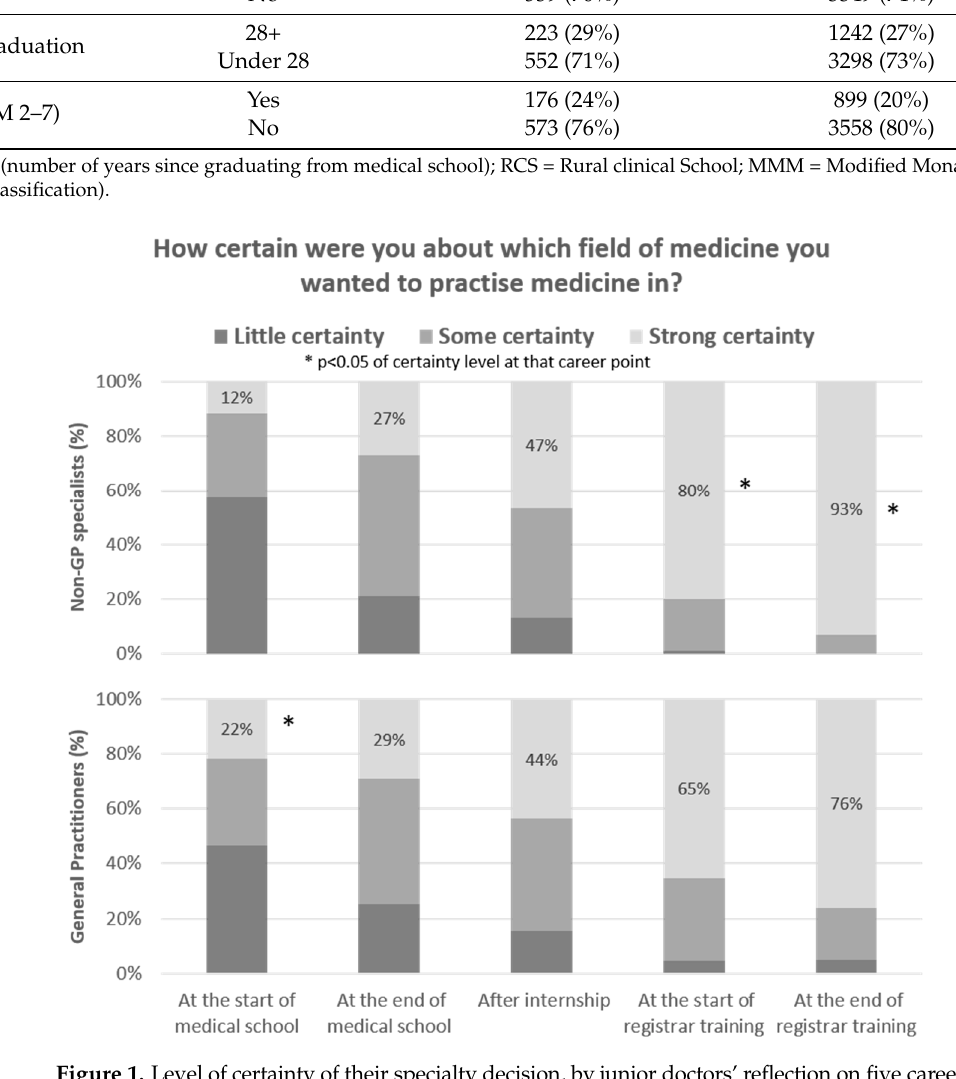
Figure 1. Level of certainty of their specialty decision, by junior doctors’ reflection on five career